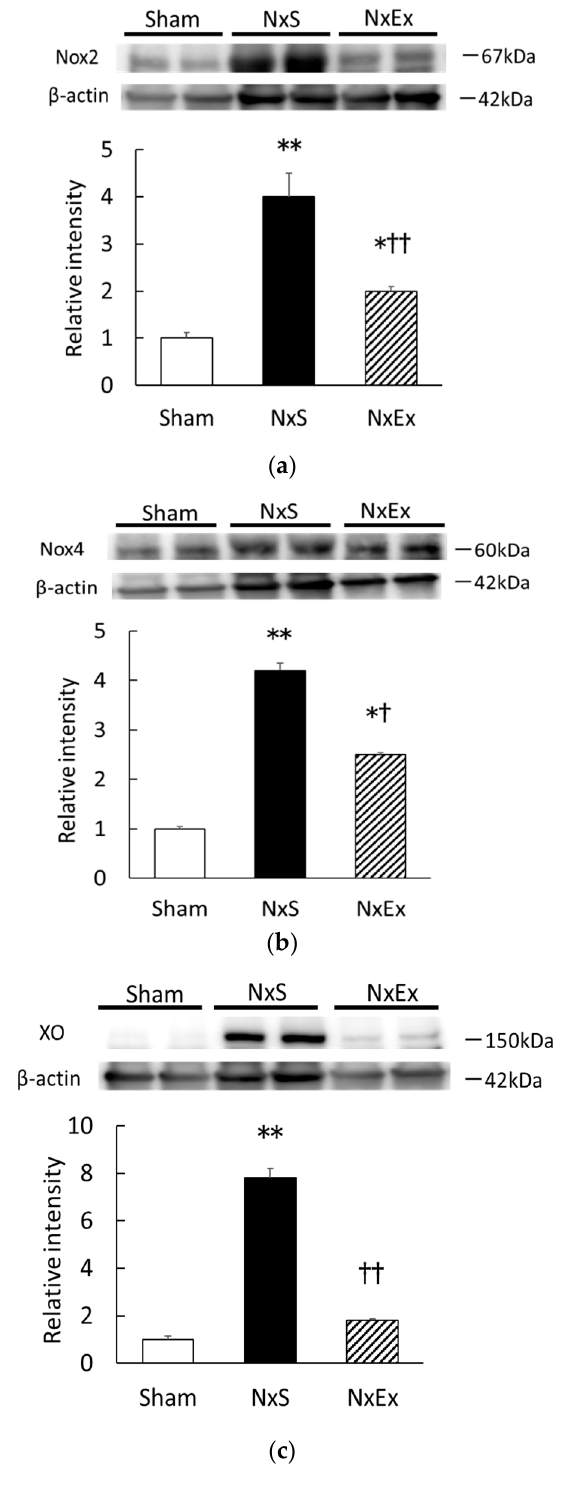
Figure 3. Effect of exercise training on the renal expression of NADPH oxidase 2 (Nox2), NADPH oxidase 4 (Nox4), and xanthine oxidase (XO). Renal cortical expressions of the Nox2 ( a ), Nox4 ( b ), and XO ( c ) were compared among the sham operation (Sham), nephrectomy sedentary (NxS), and nephrectomy exercise (NxEx) groups. The intensities of each protein were normalized against those of β -actin. The intensity of the band in the Sham group was assigned a value of 1. Values are the means ± SEM. * p < 0.05, ** p < 0.01 compared with the sham group, † p < 0.05, †† p < 0.01 compared with the NxS group.